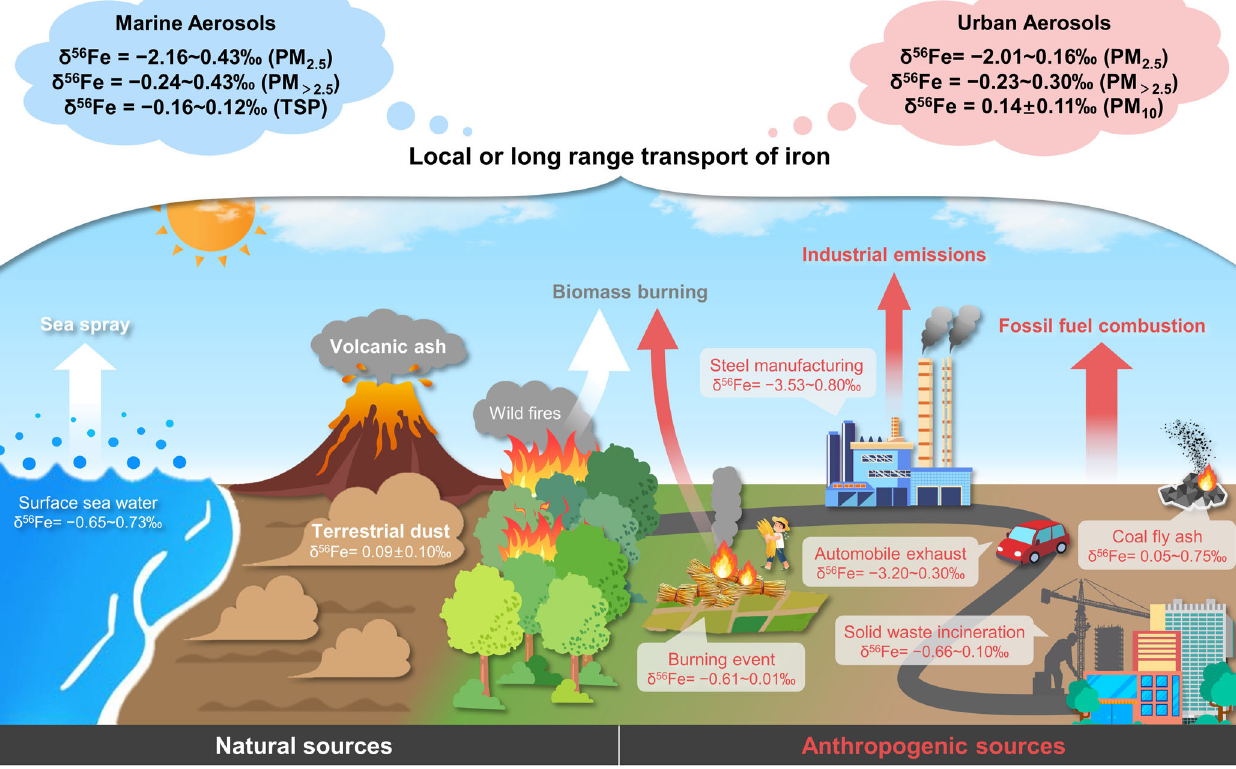
Fig. 5 Graphical illustration of the emission from natural and anthropogenic sources to atmospheric iron. The δ 56 Fe values of iron sources, including surface sea water 52,134 , terrestrial dust 125 , burning event 140 , steel manufacturing 142,147 , coal fl y ash 128,146 , solid waste incineration 141,146 and exhausted gasoline 141 , are according to published literature (There are no data for volcanic ash and wild fi res, etc.). Iron isotopic variations in both fi ne and coarse particles in marine 71,127,128,148,152,155 and urban aerosols 147,148,150 are also